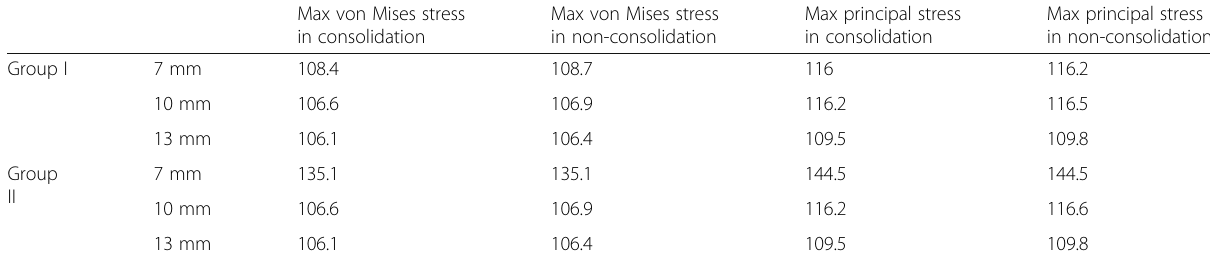
Table 9 Stresses in the implant in group I and group II consolidated and non-consolidated models